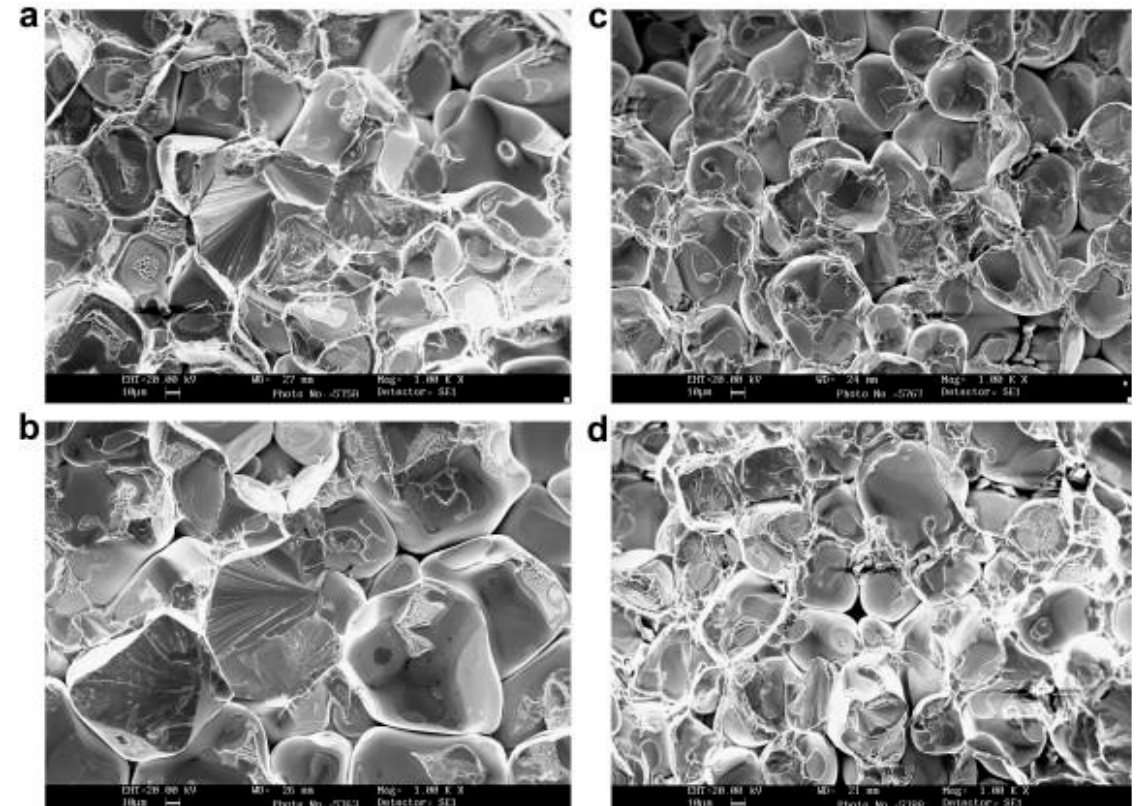
Figure 15. SEM fractography images of W–Ni–Cu-heavy alloy [90]. ( a ) W-94.9, Ni-3.4, Cu-1.7 alloy, ( b ) W-96.1, Ni-2.8, Cu-1.1 alloy, ( c ) W-92.5, Ni-5, Cu-2.5 alloy and ( d ) W-96.0, Ni-2.8, Cu-1.1, Fe-0.1 alloy.